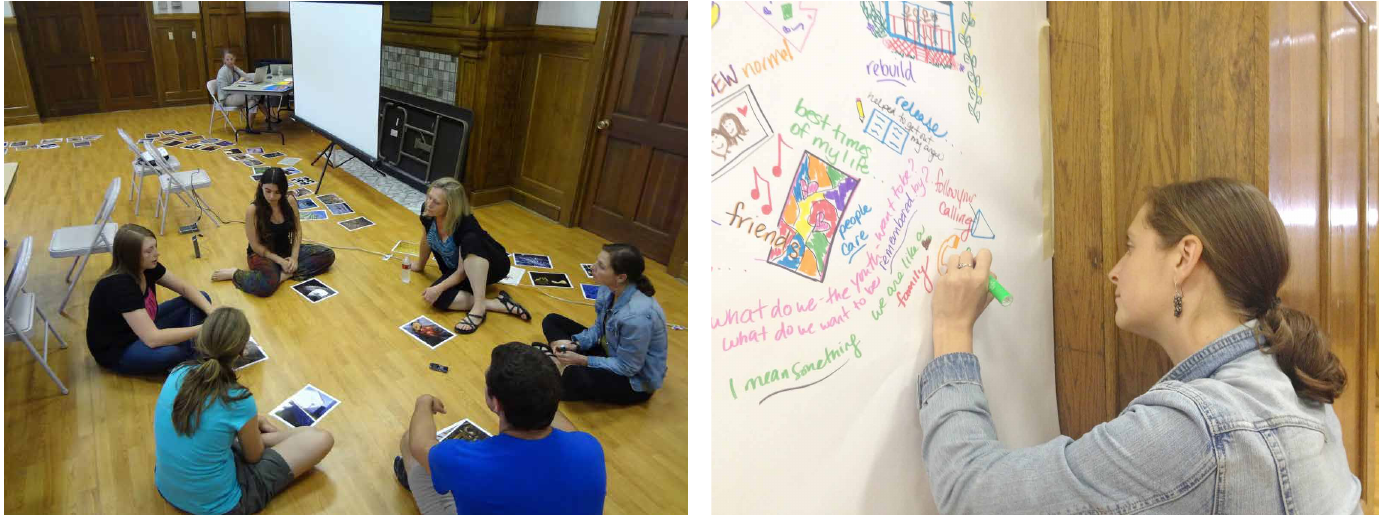
Figure 3: The Visual Explorer™ activity provided an entry point into discussion and storytelling. Figure 4: Graphic recording creates a visual story of the workshop